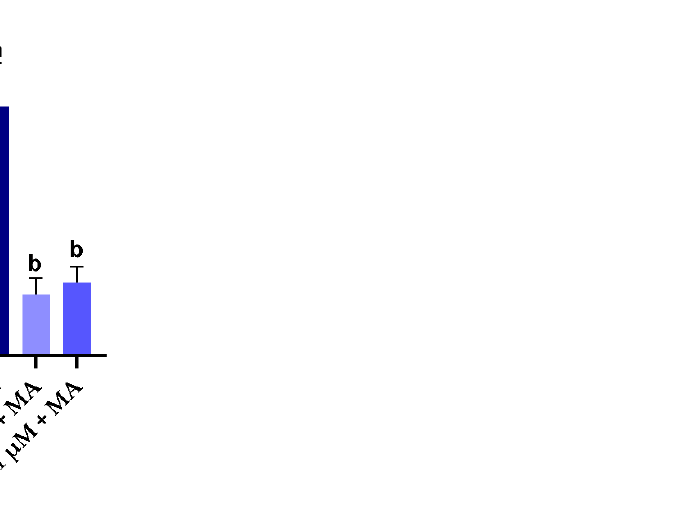
Figure 3. Average and standard error of Rhipicephalus microplus hemocytes circulating in the hemolymph 24 h after inoculation of the antagonist SCH 23390 and Metarhizium anisopliae LCM S04. Bars with the same letter do not differ statistically according to one-way ANOVA followed by Tukey ’ s test ( p < 0.05). CTR: untreated ticks; PBS: ticks inoculated with phosphate buffer solution; SCH 1 nM: ticks inoculated with the antagonist at 1 nM; SCH 1 µM: ticks inoculated with the antagonist at 1 µM; MA: ticks inoculated with M. anisopliae ; SCH 1 nM + MA: ticks inoculated with the lowest concentration of antagonist and fungus; SCH 1 µ M + MA: ticks inoculated with the highest concentration of the antagonist and fungus.